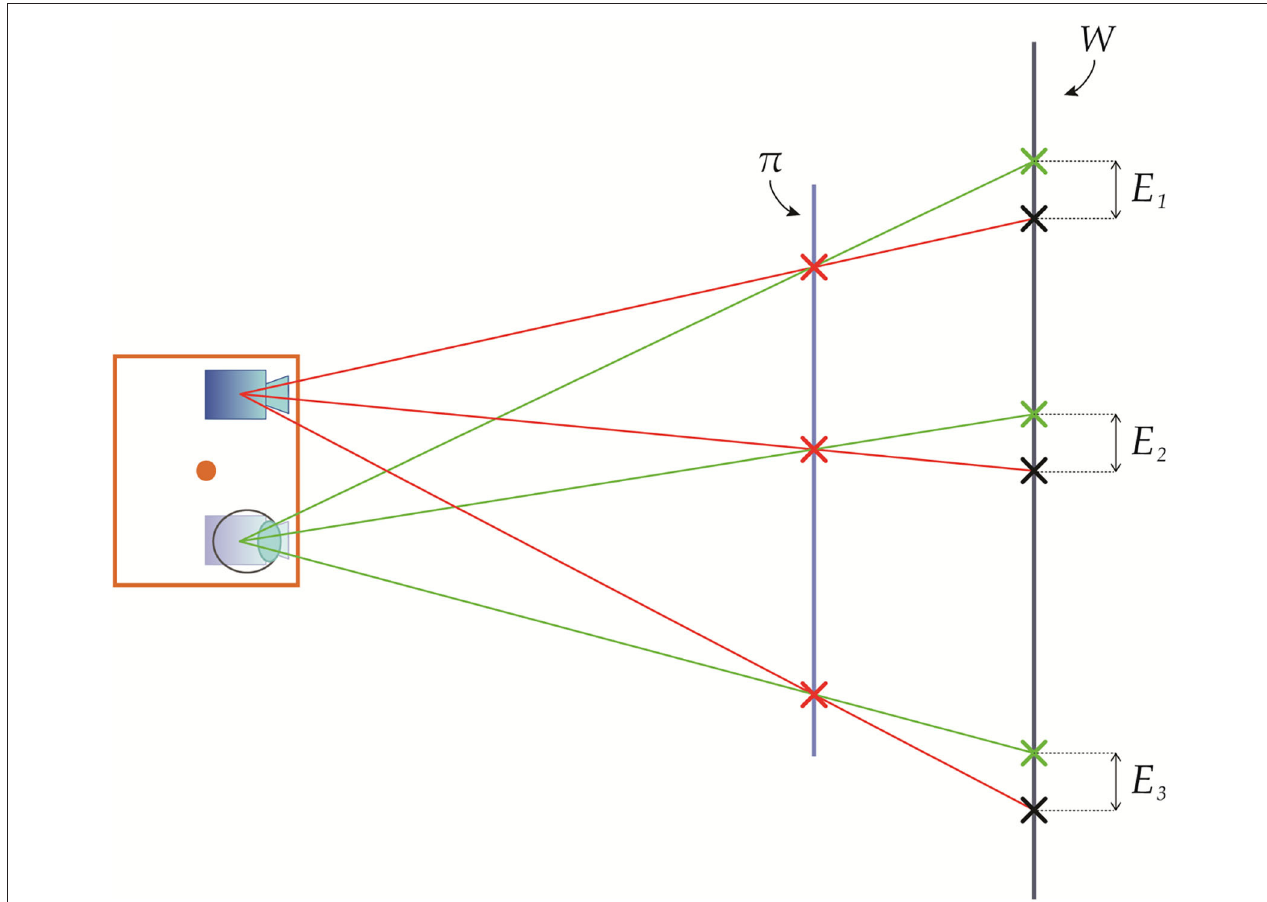
FIGURE 4 | Geometrical representation of the registration error due to the viewpoint shift between a viewpoint position and a calibration position for world points located exactly at the image plane and outside the image plane of the OST display.